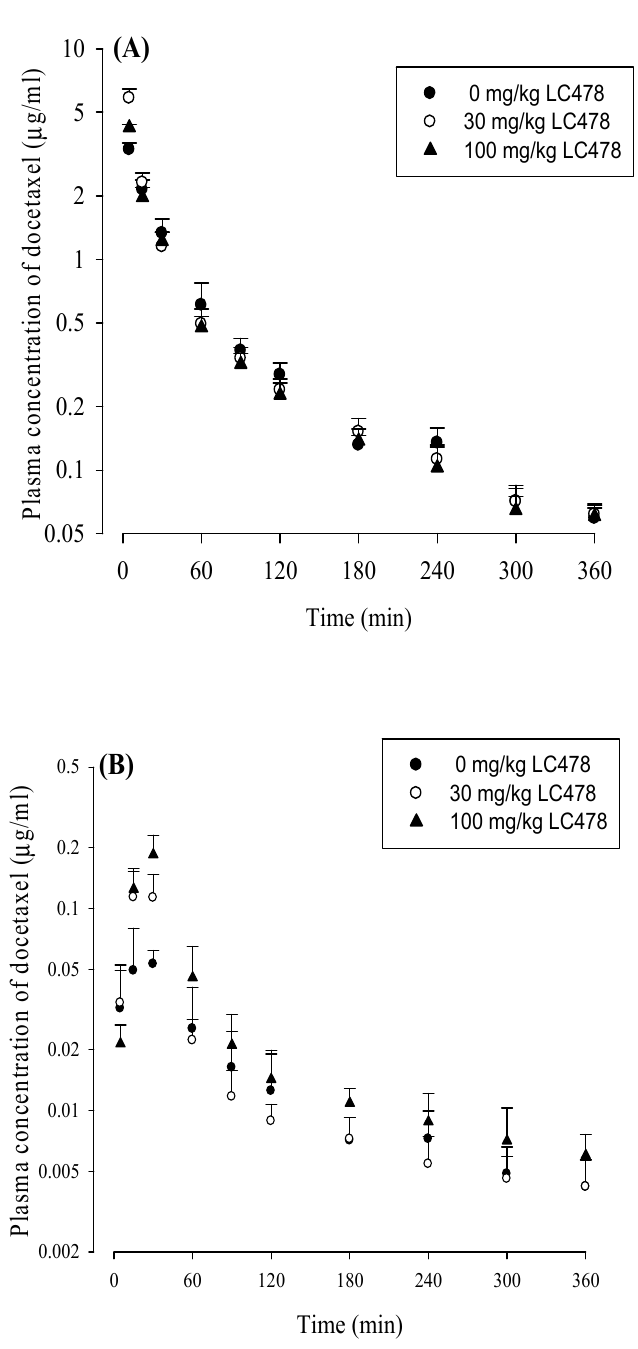
Figure 4. ( A ) Mean arterial plasma concentration–time profiles of docetaxel after its intravenous administration with 0 ( ○ ; n = 6), 30 ( ● ; n = 6) or 100 ( ▲ ; n = 6) mg/kg LC478 in rats. ( B ) Mean arterial plasma concentration–time profiles of docetaxel after its oral administration with 0 ( ○ ; n = 5), 30 ( ● ; n = 6), and 100 ( ▲ ; n = 6) mg/kg LC478 in rats. Vertical bar represents SD.